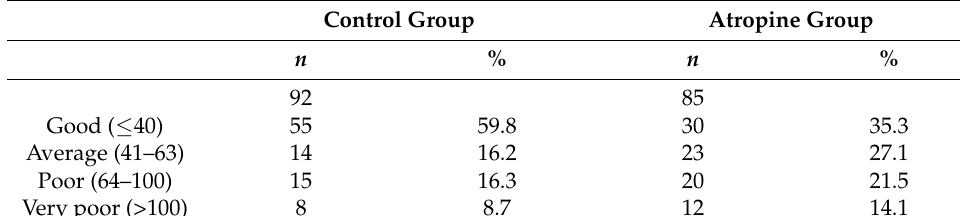
Table 3. Comparison of the stereo acuities between the atropine group and the control group.